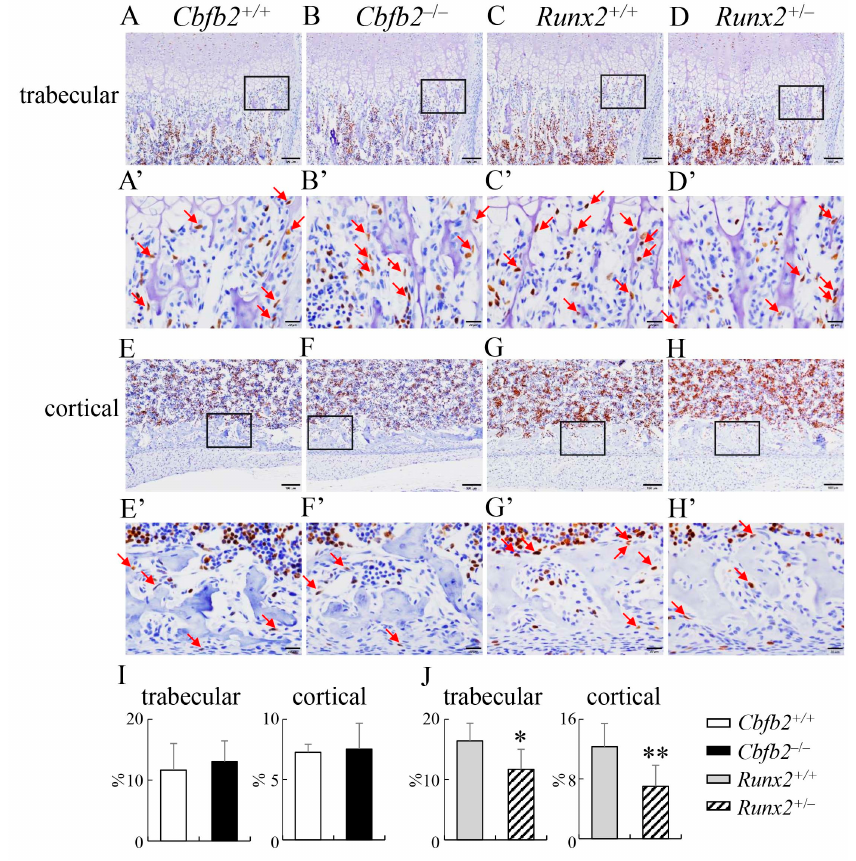
Figure 16. Proliferation of osteoblast ‐ like and osteoprogenitor ‐ like cells in the trabecular and cortical bone of femurs. ( A – H ) BrdU staining of trabecular bone ( A – D ) and cortical bone ( E – H ) in femurs from Cbfb2 +/+ ( A , E ), Cbfb2 –/– ( B , F ), Runx2 +/+ ( C , G ) and Runx2 +/– ( D , H ) mice at P7. The boxed regions in ( A – H ) are magnified in ( A’ – H’ ), respectively. Arrows in ( A’ – H’ ) show BrdU ‐ positive osteoblast ‐ like or osteoprogenitor ‐ like cells. Scale bars: 100 μ m ( A – H ) and 20 μ m ( A’ – H’ ). ( I , J ) Frequencies of BrdU ‐ positive osteoblast ‐ like and osteoprogenitor ‐ like cells in trabecular and cortical bone in Cbfb2 +/+ and Cbfb2 –/– mice ( I ) and Runx2 +/+ and Runx2 +/– mice ( J ). Data are shown as the mean ± SD. * p < 0.05, ** p < 0.01. The number of mice analyzed: Cbfb2 +/+ , n = 7; Cbfb2 –/– , n = 5; Runx2 +/+ , n = 5; Runx2 +/– , n = 9.